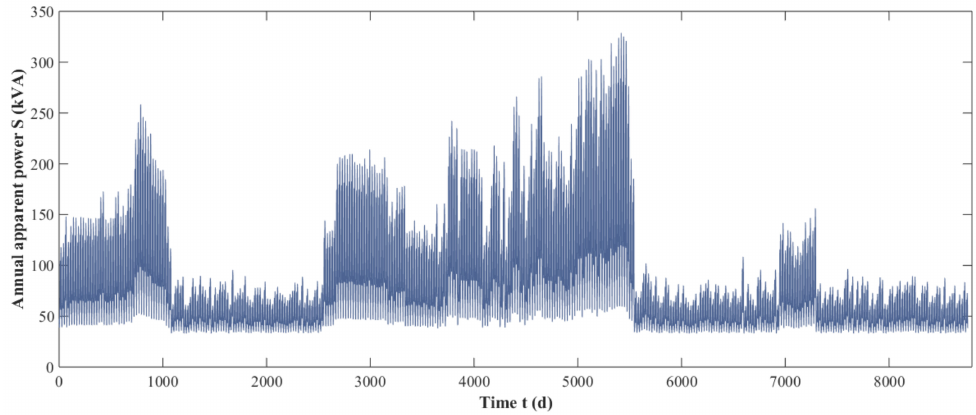
Figure 4. Annual apparent power curve at node 6 in the first year of electric energy